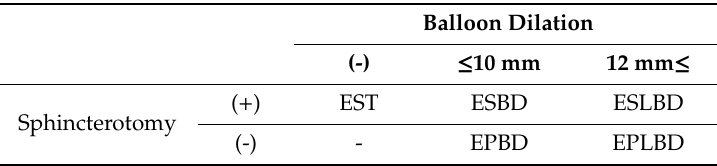
Table 1. Types of endoscopic procedure on the